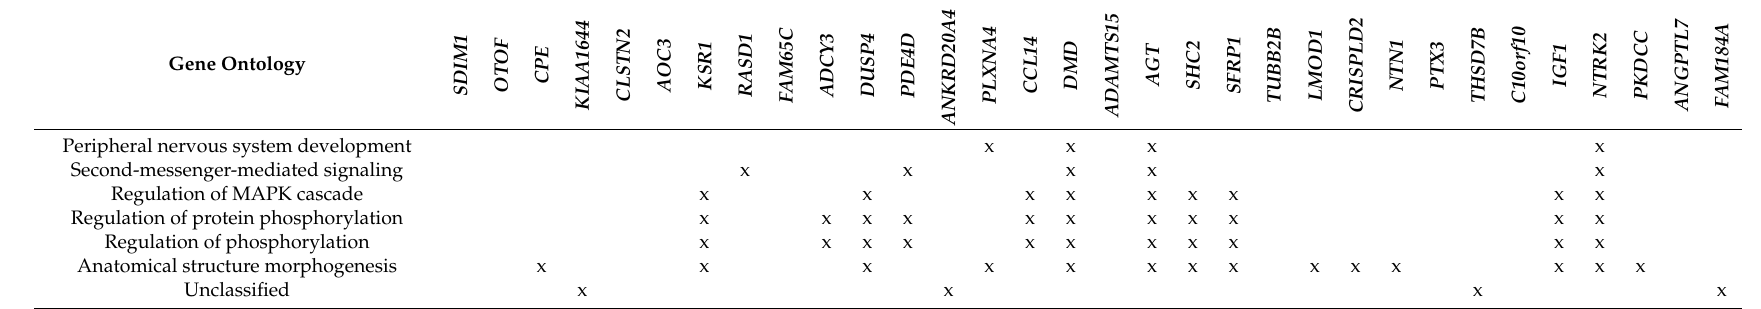
Table 4. Gene Ontologies (GO) in the category of biological process and 18 enriched genes among 32 differentially expressed in synovial tissue of patients with contrast pain phenotypes. All enriched genes are up regulated in painful knee (Table 2).